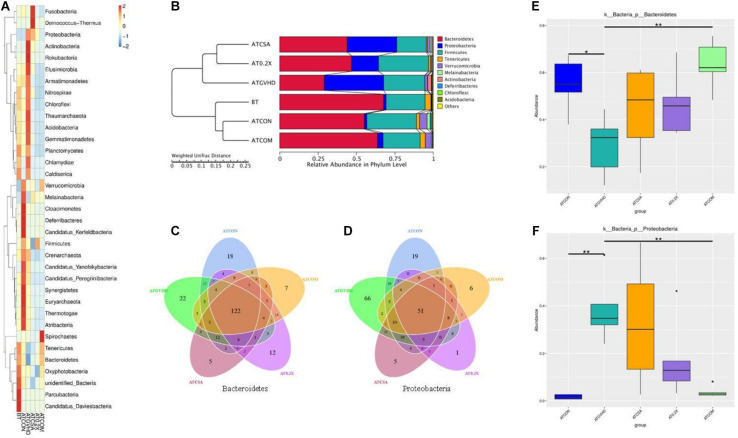
The combination of XBJ and CsA reversed the dysbiosis at the phylum level in GVHD mice. (A) The cluster heat map of the abundance of gut microbiota at the phylum level in different groups of mice. The alteration of intestinal bacterial patterns at the phylum level in different groups of mice was assessed using 16S high-throughput sequencing after BMT on day 7, n = 4–6/group. The heat map is color-based on row Z scores. The mice with the highest and lowest bacterial level are in red and blue, respectively. (B) Unweighted Pair-Group Method with Arithmetic (UPGMA) mean tree based on weighted UniFrac at the phylum level. The relative abundances of enteric bacteria at the phylum level in different groups of mice were assessed using 16S high-throughput sequencing after BMT on day 7. n = 4–6/group. The proportion of relative abundance of Bacteroidetes and Proteobacteria was decreased in aGVHD mice compared to control mice, and the combination treatment reversed this change. (C) OTU-based Venn graph in Bacteroidetes of different groups. The number of OTUs in the phylum of Bacteroidetes in different groups was analyzed using 16S high-throughput sequencing after BMT at day 7. n = 4–6/group. (D) OTU-based Venn graph in Proteobacteria of different groups. The number of OTUs in the phylum of Proteobacteria in different groups was analyzed using 16S high-throughput sequencing after BMT on day 7. n = 4–6/group. (E) MetaStat analysis of Bacteroidetes in different groups to evaluate the influences of treatments on the relative abundance. All values are mean ± SEM (n = 4–6/group). *Adjusted p < 0.05, **adjusted p < 0.01. (F) MetaStat analysis of Proteobacteria of different groups to evaluate the influences of treatments on the relative abundance of Bacteroidetes. All values are mean ± SEM (n = 4–6/group). *Adjusted p < 0.05, **adjusted p < 0.01.